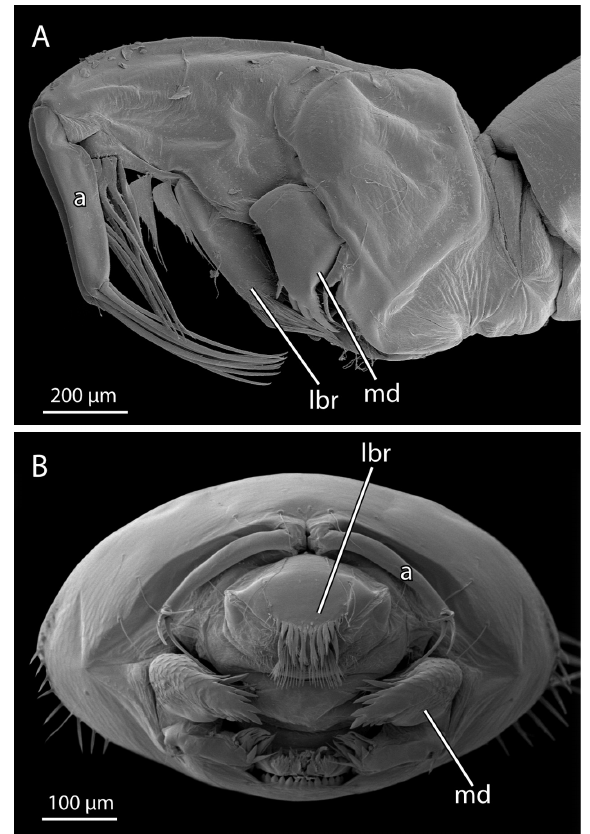
Figure 5 . Labellae, SEM images. A, Aedes sp. (Culicidae), frontal. B, Tipula paludosa (Tipulidae), dorsal.